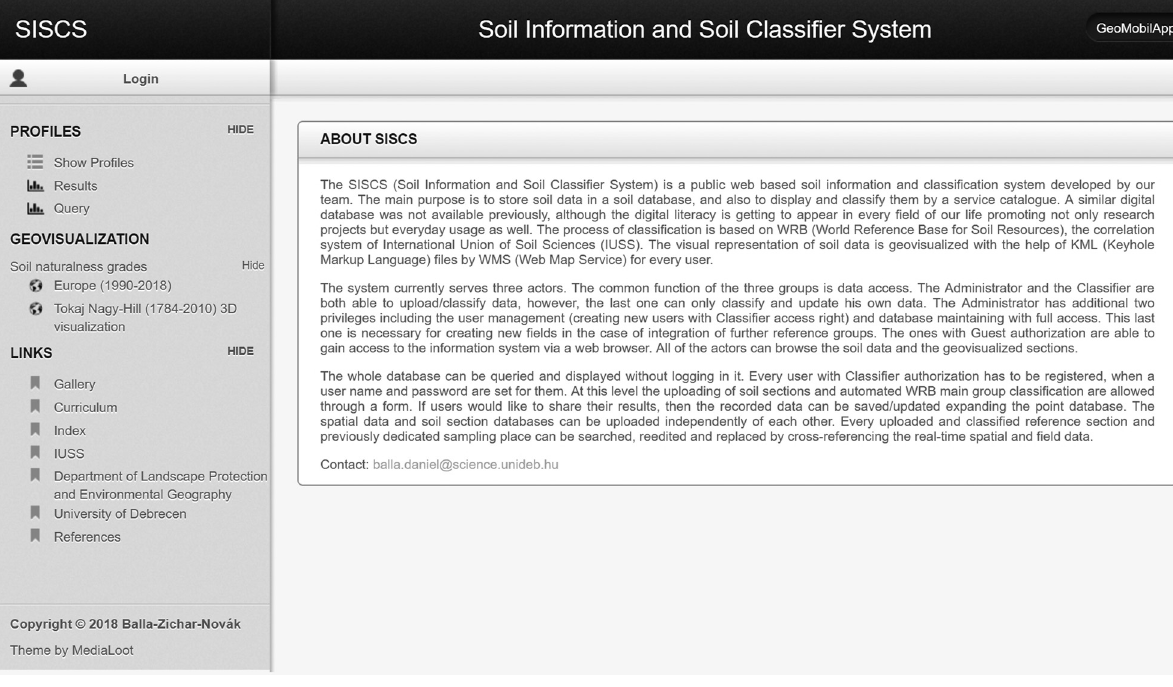
Figure 6: Index page of